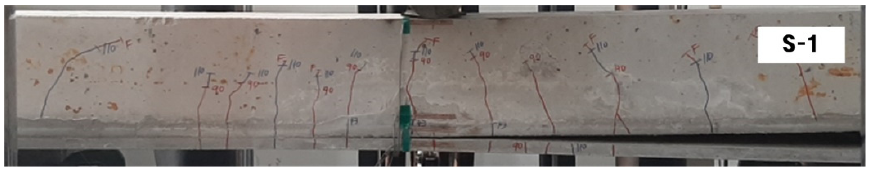
Figure 12. Failure mechanism of the S ‐ 1 specimen [17].